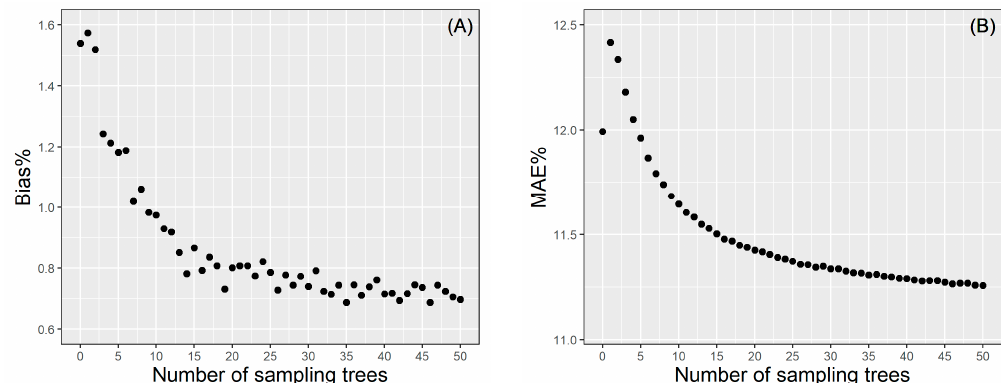
Figure 6. The Bias% ( A ) and MAE% ( B ) of the site-level